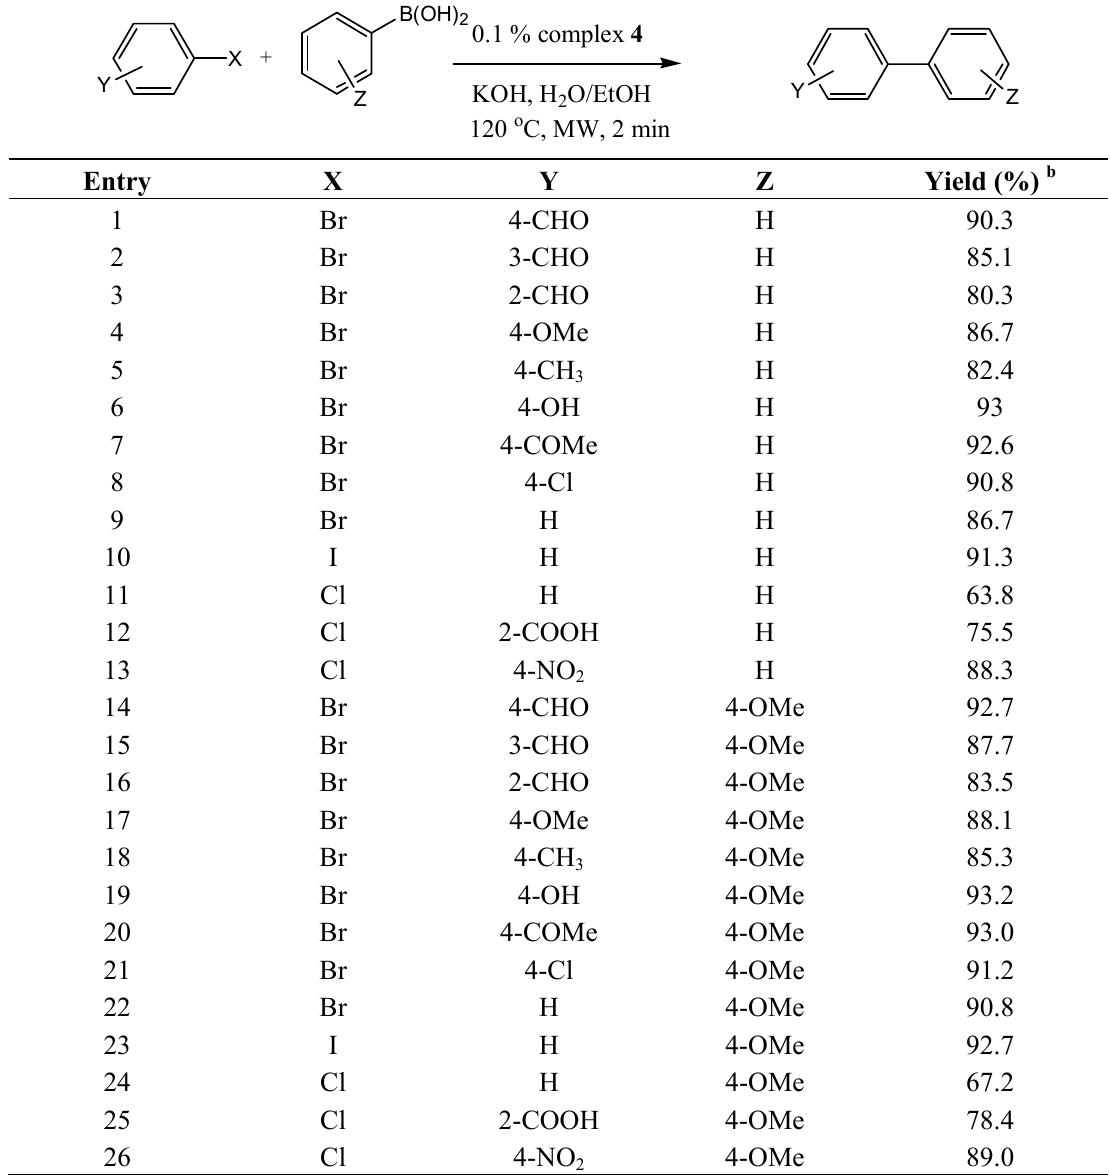
Table 2. Suzuki coupling of aryl halides and aryl boronic acids in H complex 4 under optimized reaction conditions under microwave irradiation a